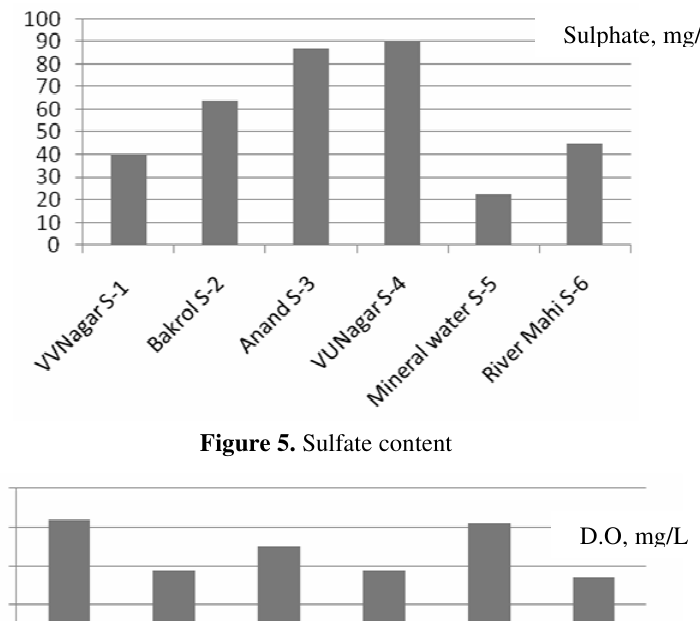
Figure 4. Chloride content